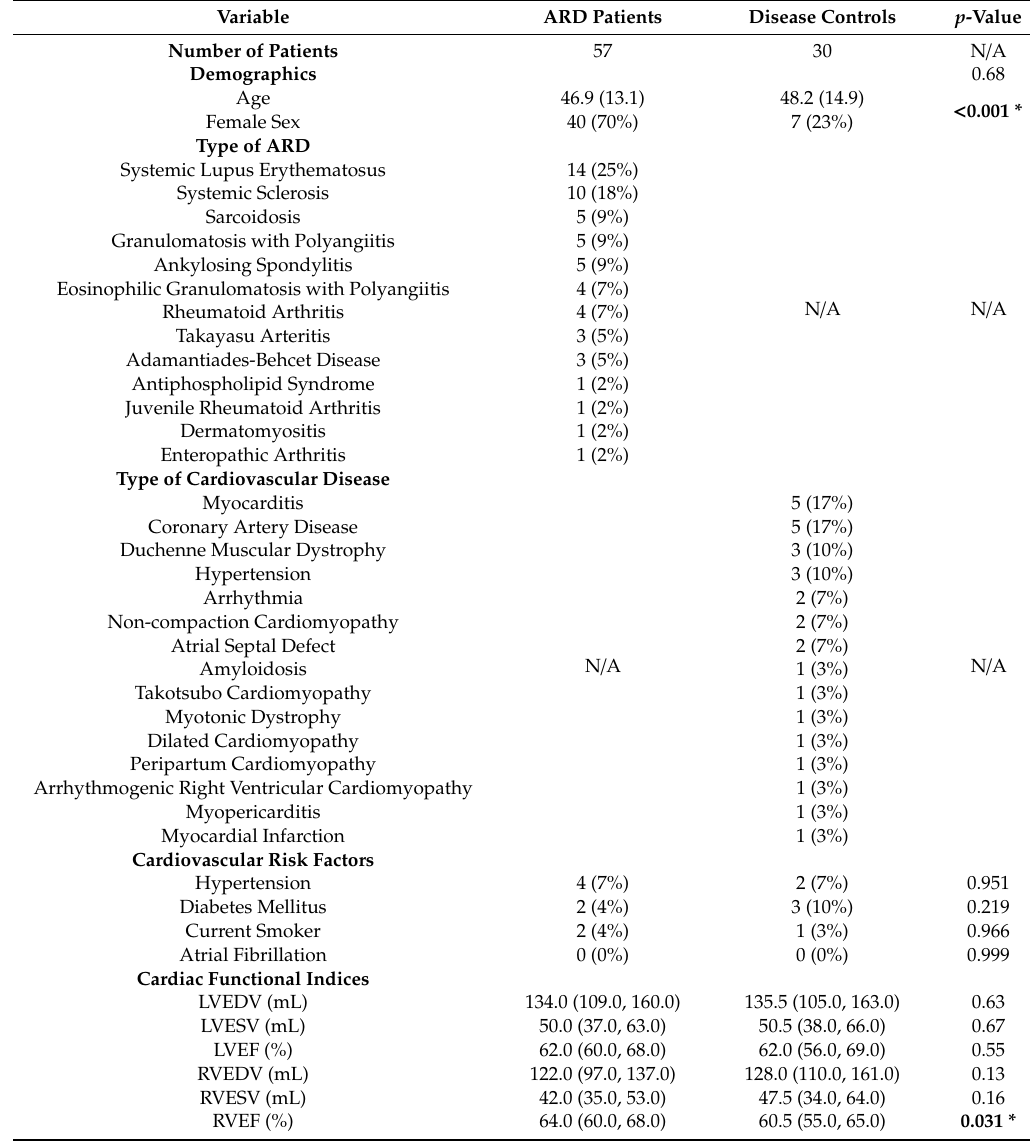
Table 1. Characteristics compared between ARD patients and disease controls. * p ≤